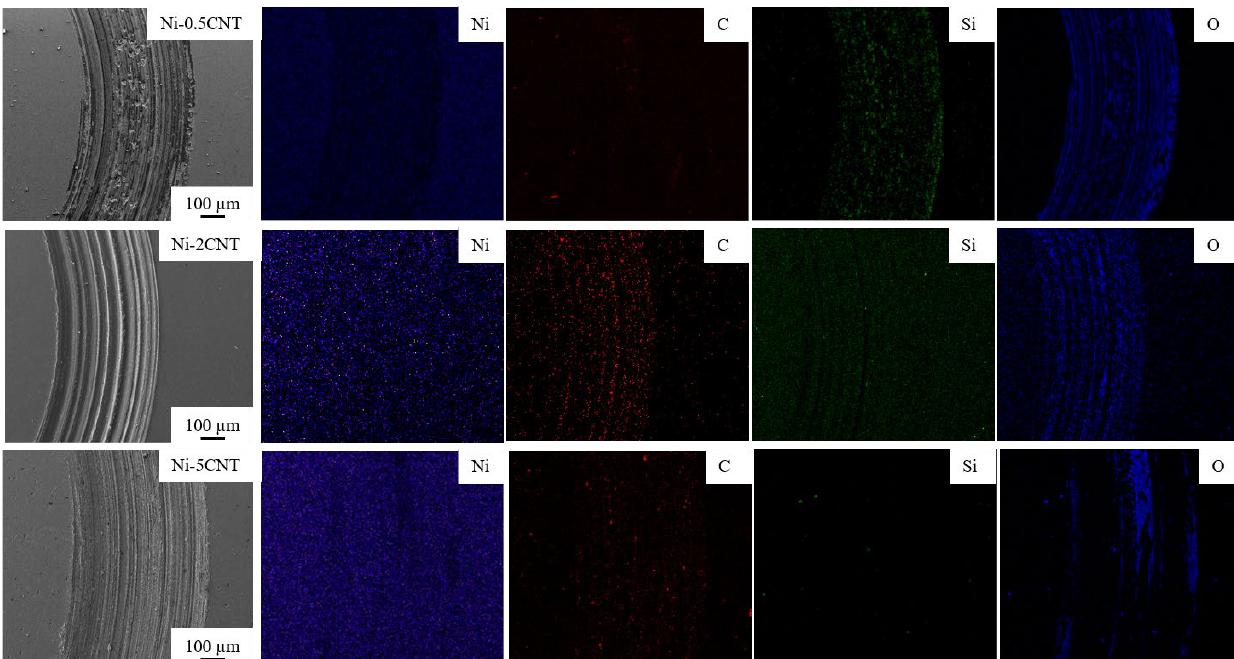
Figure 8. EDS maps of wear track on Ni-CNT composites.